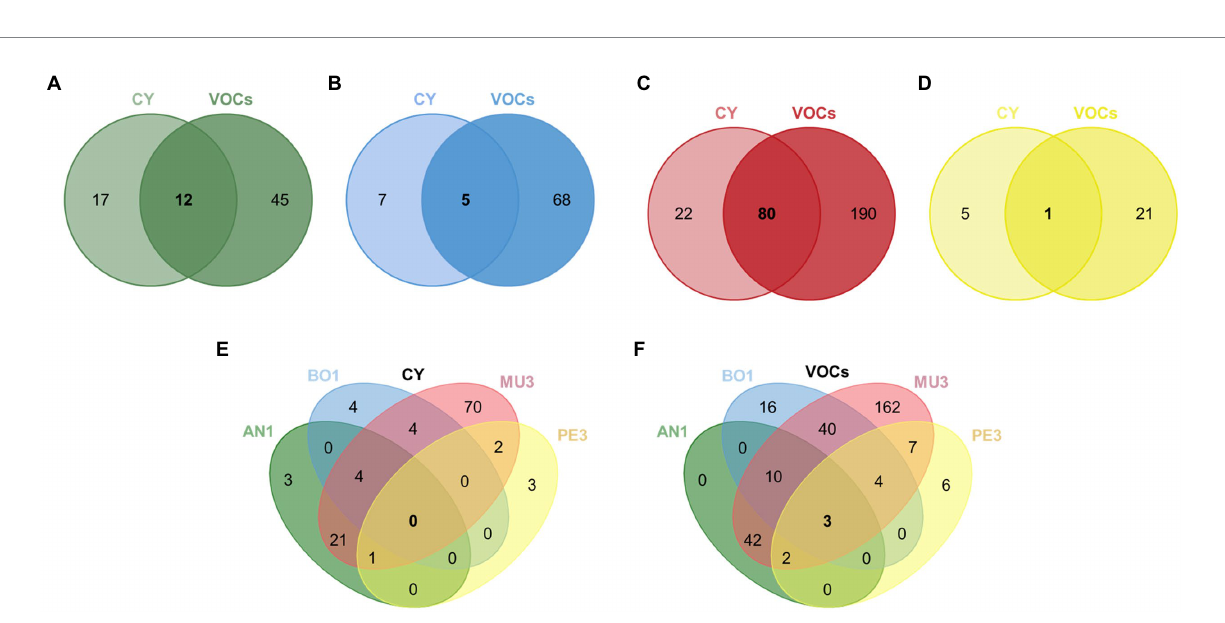
FIGURE 6 Venn diagrams illustrating the number of yeast strains with inhibitory activity against each target individually, Aspergillus nige r AN1 (A) , Botrytis cinerea BO1 (B) , Mucor sp. MU3 (C) and Penicillium sp. PE3 (D) , or against all targets (E,F) mediated by diffusible (CY) and volatile compounds (VOCs). The number of strains classified on class 3 (strong effect: 50% ≤ IAC < 75%) or class 4 (very strong effect: IAC ≥ 75%) for each mold target were included, except for MU3 in the CY assay, where only strains classified on class 2 were included (moderate effect: 25% ≤ IAC <